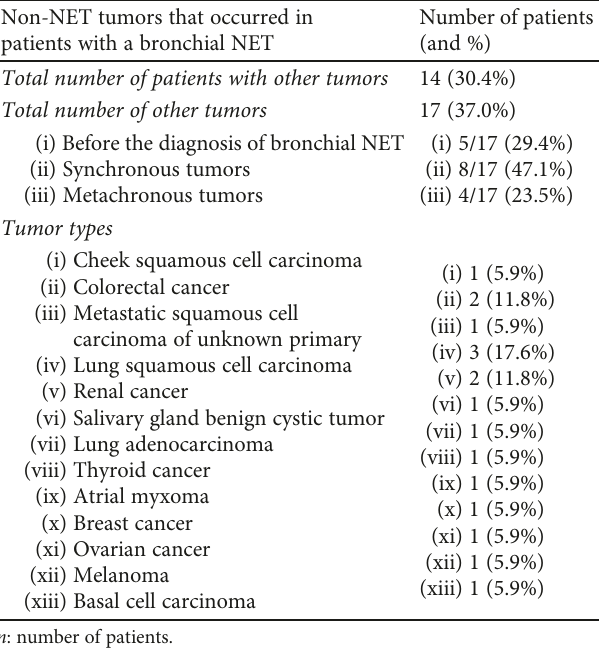
Table 8: Other tumor types recorded in bronchial NET patients diagnosed, treated, or followed-up at our institution from 1 st January 1995 to 31 st December 2015 ( n = 46 ).